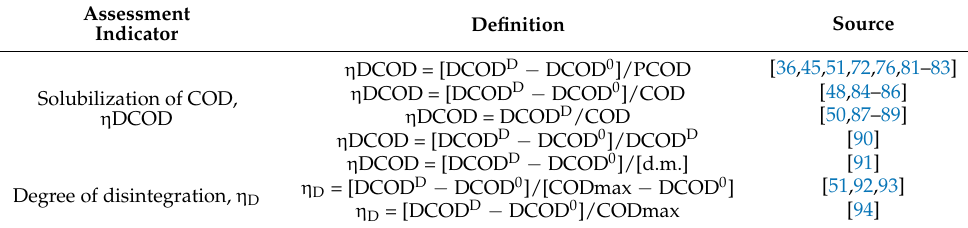
Table 3. Indicators of assessment of the degree of